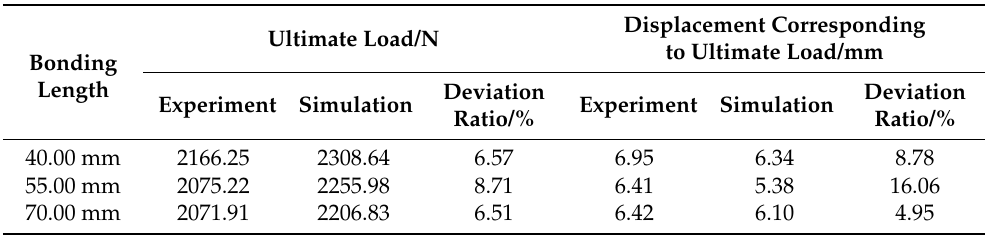
Figure 12. The load–displacement curve and its first derivative curve of the compression simulation of the L-joint, and ( A ) The first load stabilization stage; ( B ) The second load stabilization stage; ( C ) The third load stabilization stage. Table 3. The comparison of the ultimate loads and corresponding displacements of different L-joint experiments and simulation curves. Displacement Corresponding Ultimate Load/N to Ultimate Load/mm Bonding Length Deviation Deviation Experiment Simulation Experiment Simulation Ratio/% Ratio/% 40.00 mm